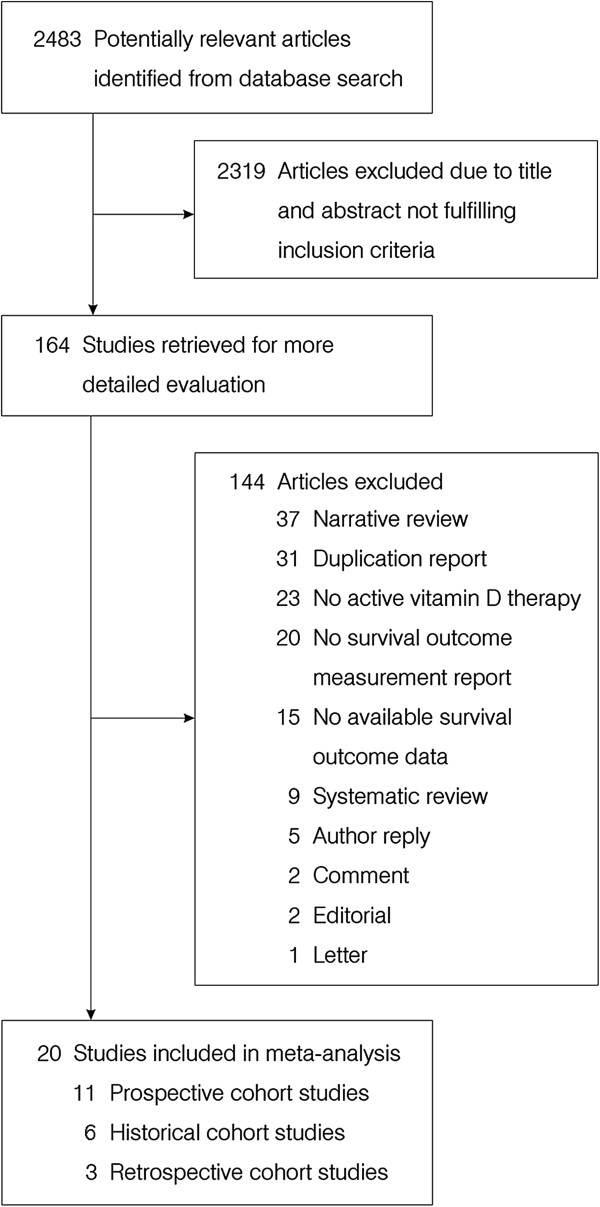
Selection process for studies included in the meta-analysis.